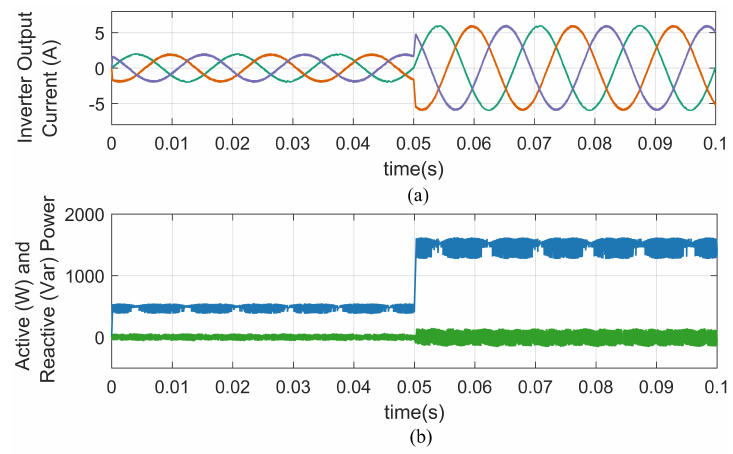
Figure 11. Simulation results with MPC. ( a ) Three-phase output current of inverter. ( b ) Active and reactive power output.